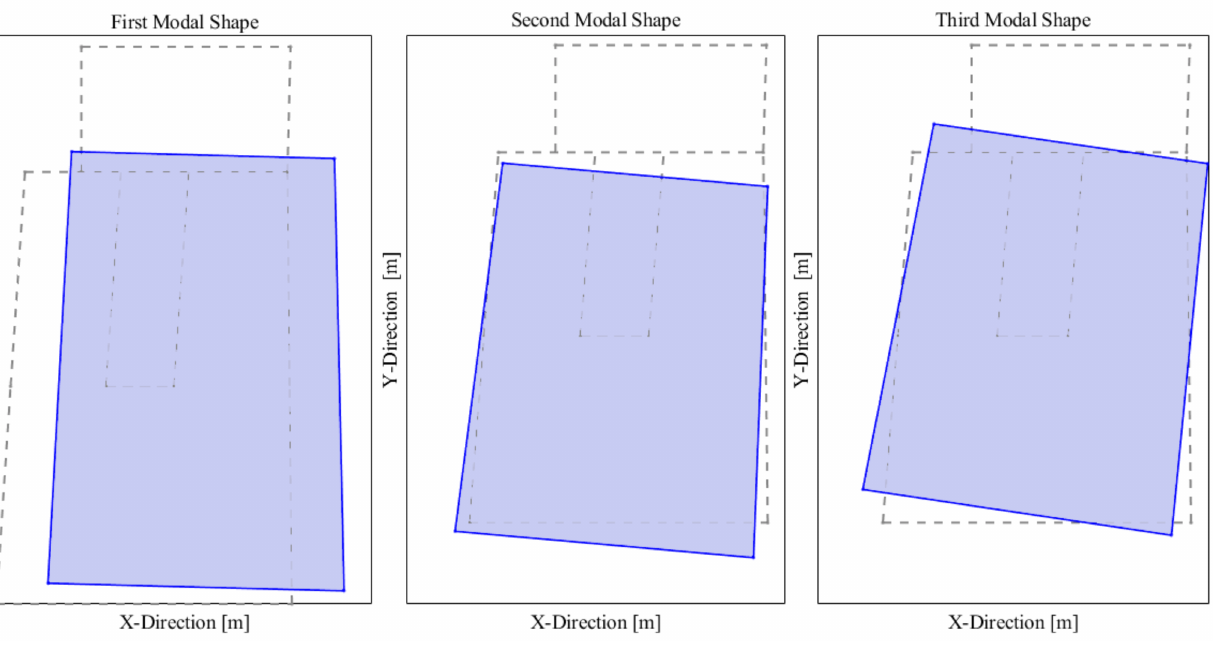
Figure 13. Numerical mode shapes after the model